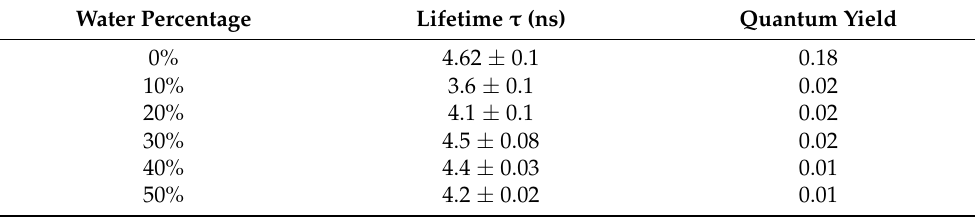
Table 1. Fluorescence lifetimes of PDI-III in THF with different water